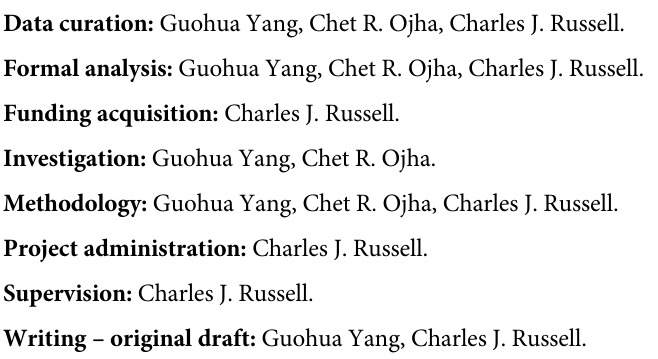
S1 Fig. Acid inactivation titrations performed using 0.5 and 0.2 pH-unit steps. Virus inacti- vation titrations were performed using Luc9.1 cells. Viruses used were A/TN/09 WT (solid cir- cles), HA1-Y17H (open triangles), and HA2-R106K (gray squares) at an MOI 0.2 PFU/cell. Virus aliquots were incubated with pH-adjusted PBS at 0.5-unit steps (A-C) or 0.2-unit steps (D-F). After reneutralization in media supplemented with TPCK-treated trypsin, virus samples were loaded onto Luc9.1 cells and then incubated for 17 h before luminescence was measured as relative light units (RLU). Midpoints of inactivation, or inactivation pH values, are listed on the panels. Dotted lines correspond to the limit of detection (3 standard deviations above the mean) of uninfected negative control samples. Error bars represent standard deviation (n = 3). Reported data are representative of three independent